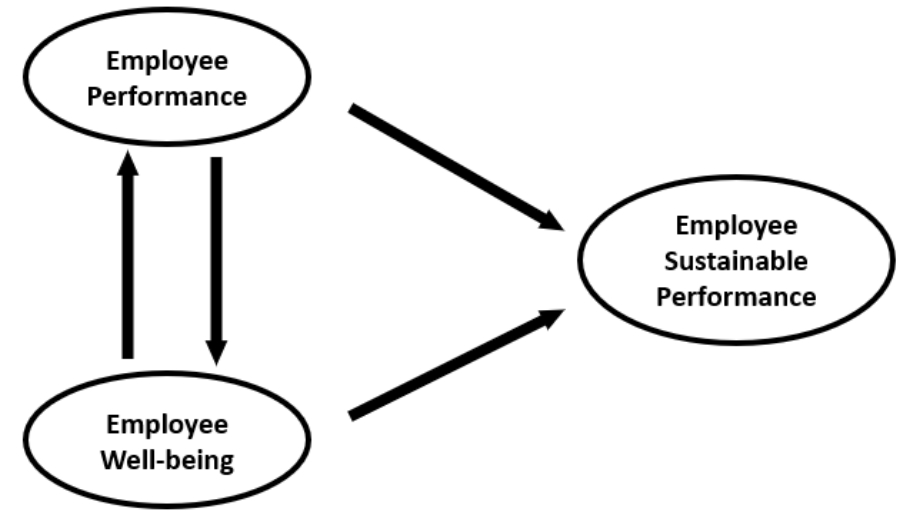
Figure 1. Proposed conceptual framework of the present study.